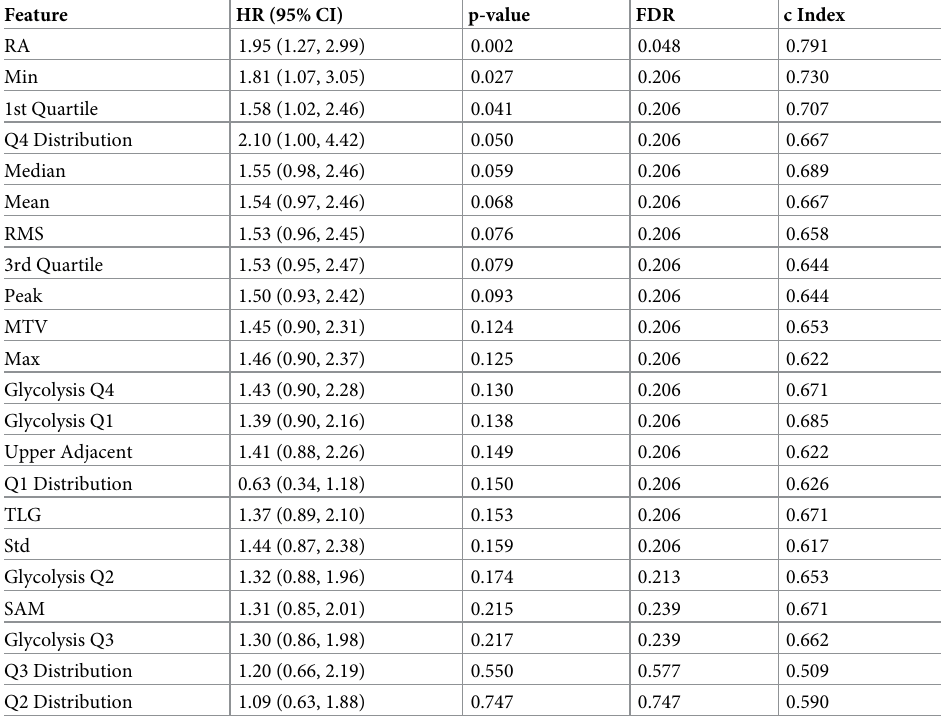
Table 4. Univariate analysis of post-treatment change in features. Features are sorted by p-values.